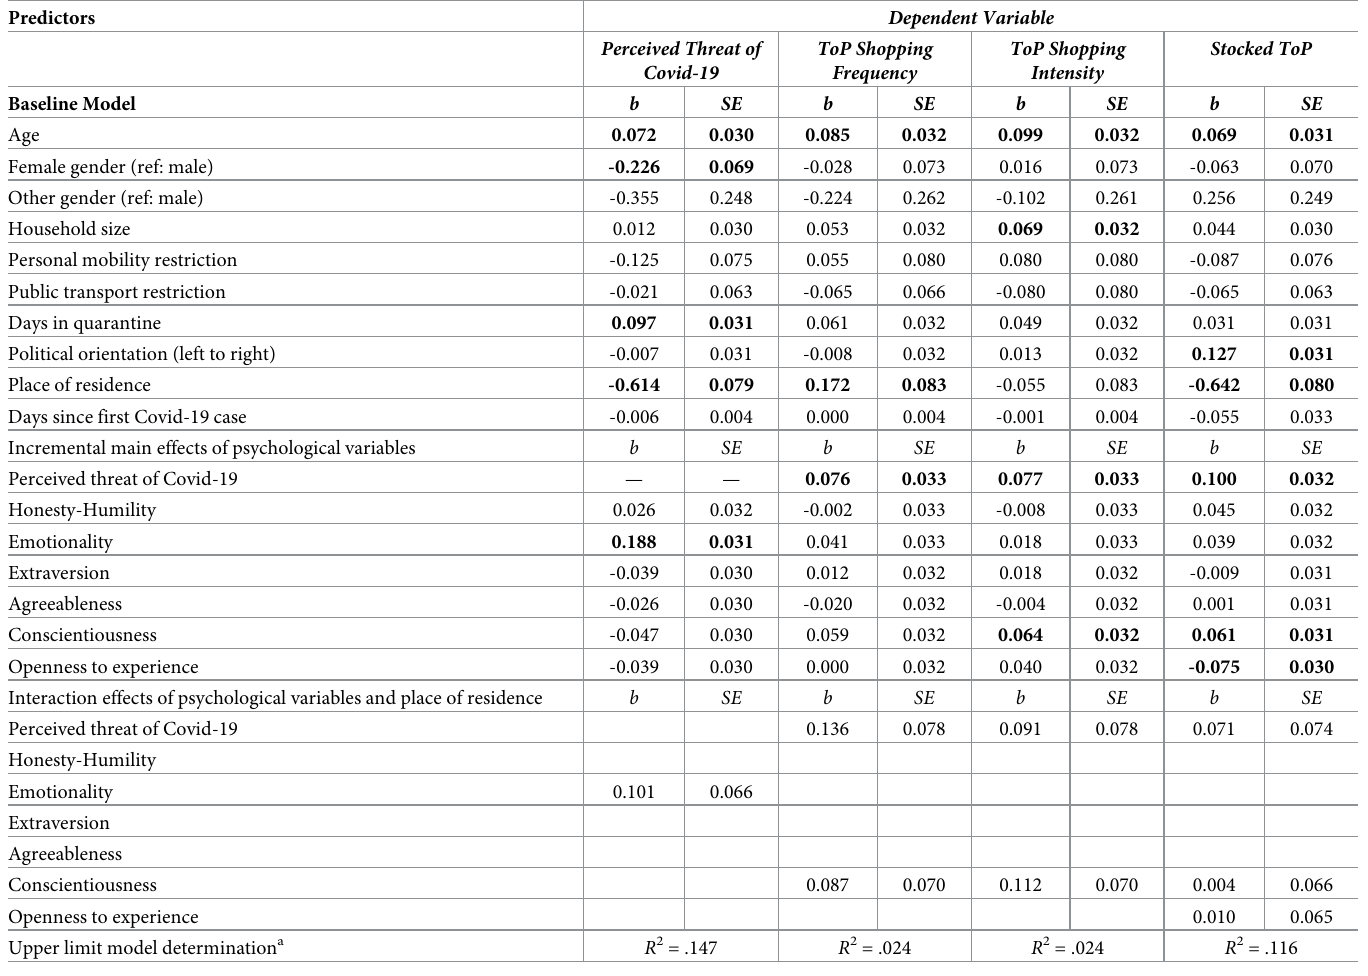
Table 2. Prediction of perceived threat of Covid-19 and toilet paper